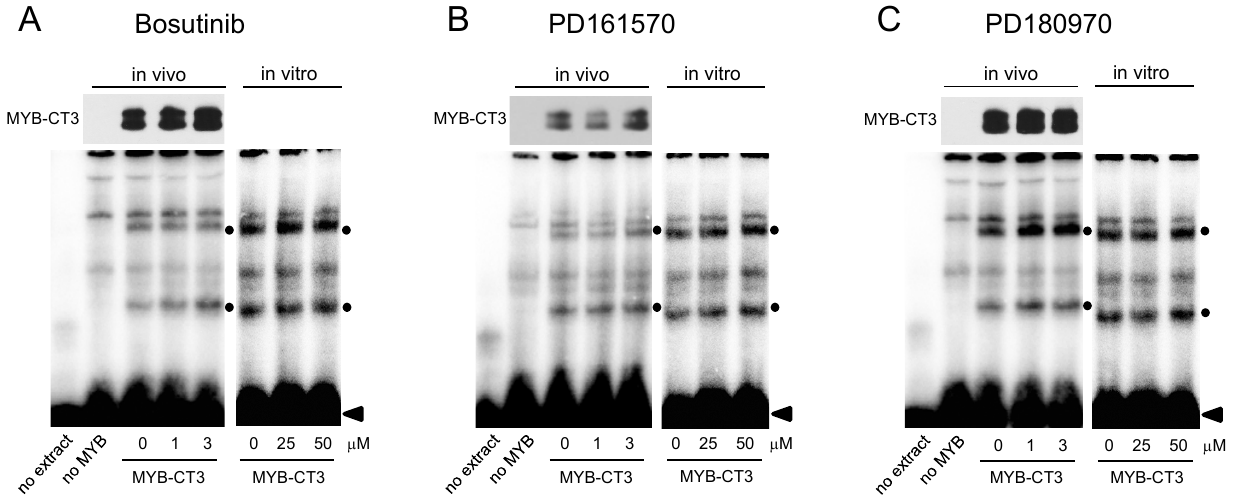
Figure 3. MYB-inhibitory compounds do not inhibit MYB DNA-binding activity. The left parts of each panel show EMSA experiments with nuclear extracts from HEK293T cells transfected without or with expression vector for MYB-CT3 and incubated for 16 h with Bosutinib ( A ), PD161570 ( B ) or PD180970 ( C ) at the indicated concentrations. Nuclear extract from un-transfected HEK293T cells was used as control. Binding assays were performed with a radiolabeled oligonucleotide containing a consensus MYB binding site. A western blot showing MYB-CT3 expression in aliquots of the nuclear extracts is presented at the top. The right part of each panel shows EMSA experiments with nuclear extracts from MYB-CT3-expressing cells supplemented with the indicated compound concentrations during the in vitro binding reactions. Black dots mark MYB-specific